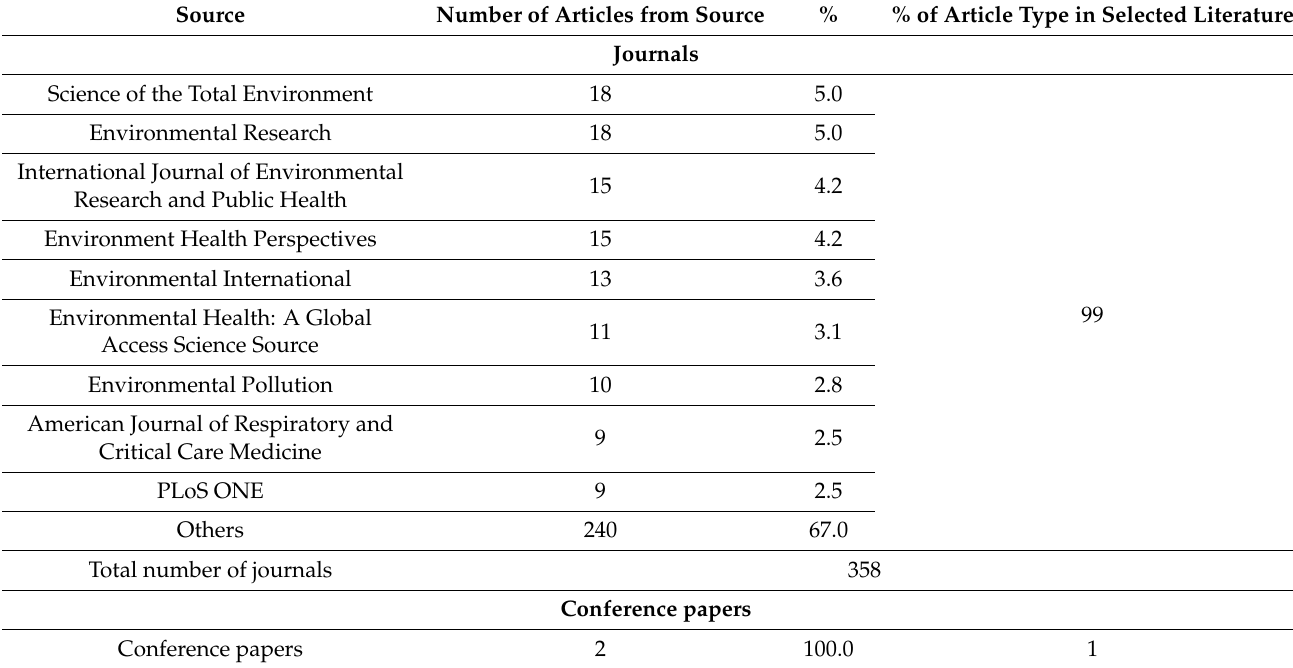
Table 1. Sources distribution of the included